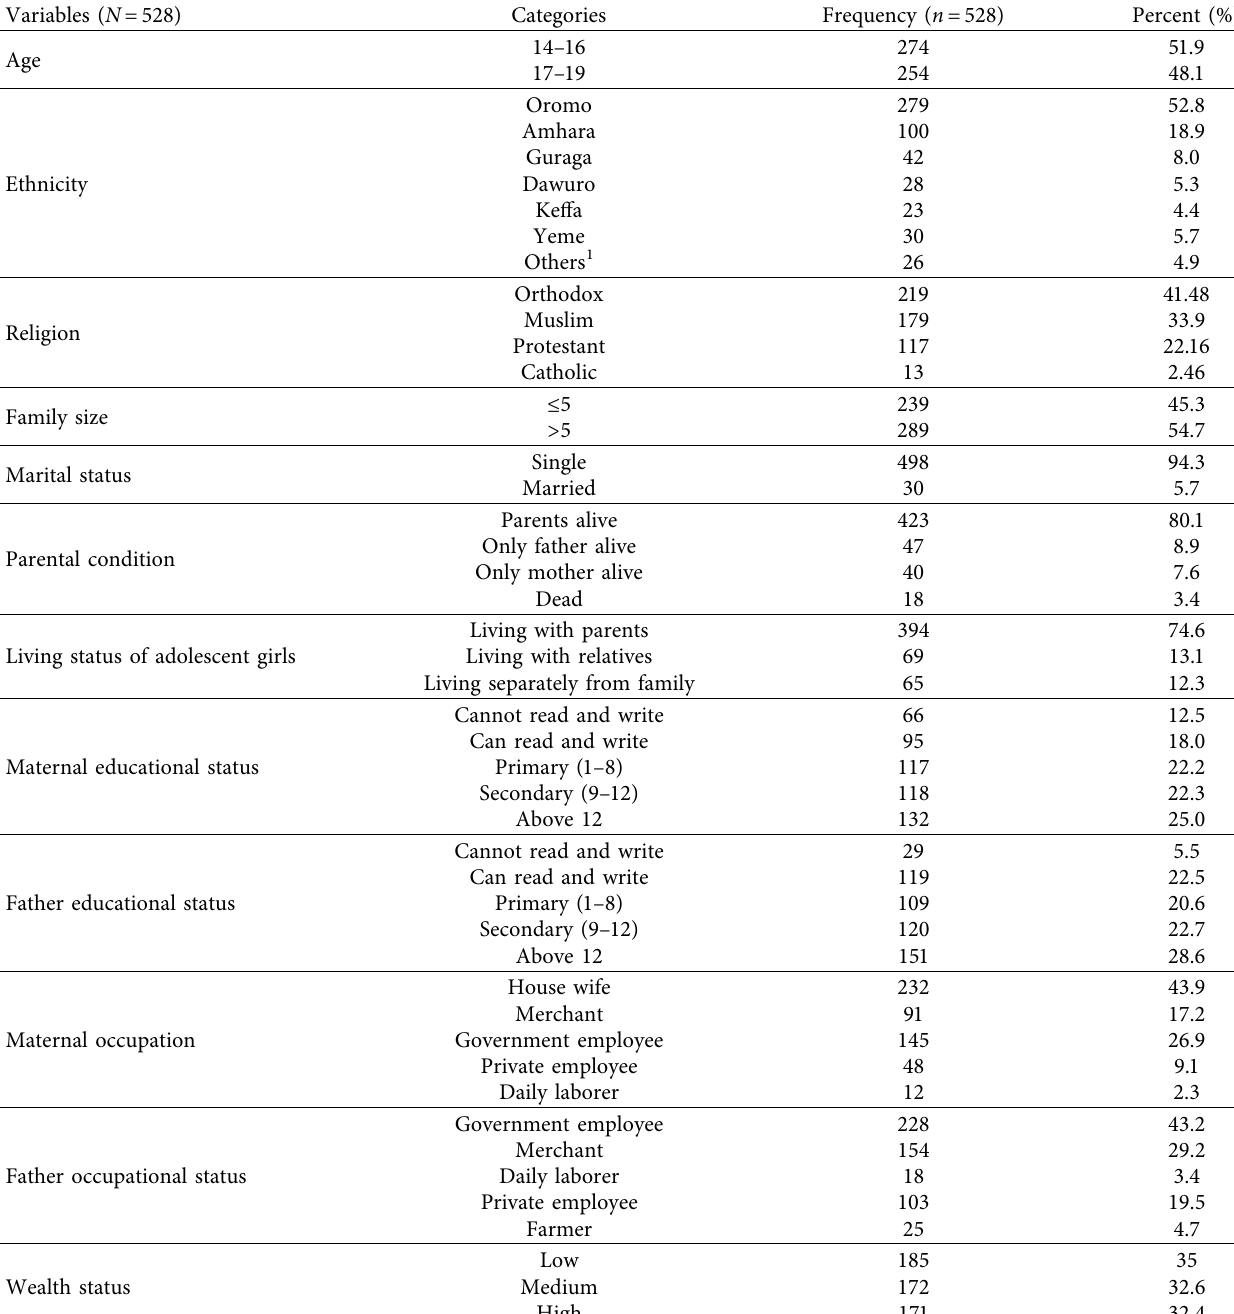
Table 1: Socioeconomic and demographic characteristics of adolescent girls and their parents in Jimma town, Oromia, southwest Ethiopia. Variables ( N �